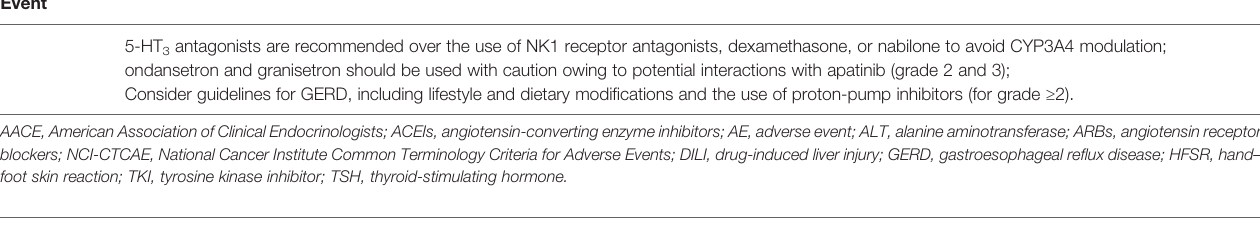
TABLE 5 | Management of hematopoietic toxicity. TKI Starting